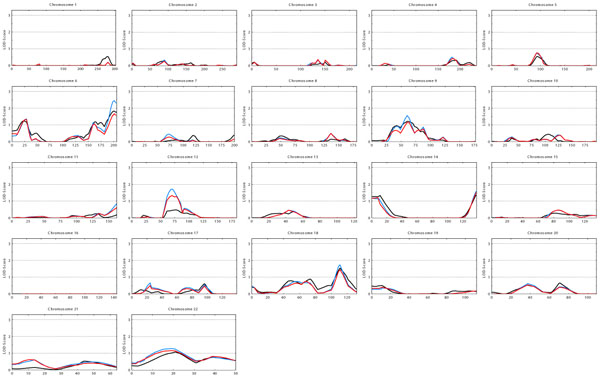
Multi-point LOD scores for height. Analysis method: SOLAR (black line), MERLIN-VC (red line), MERLIN-REGRESS (blue line). For ease of presentation, negative LOD scores from MERLIN-REGRESS were set to 0. Positions are given in cM.